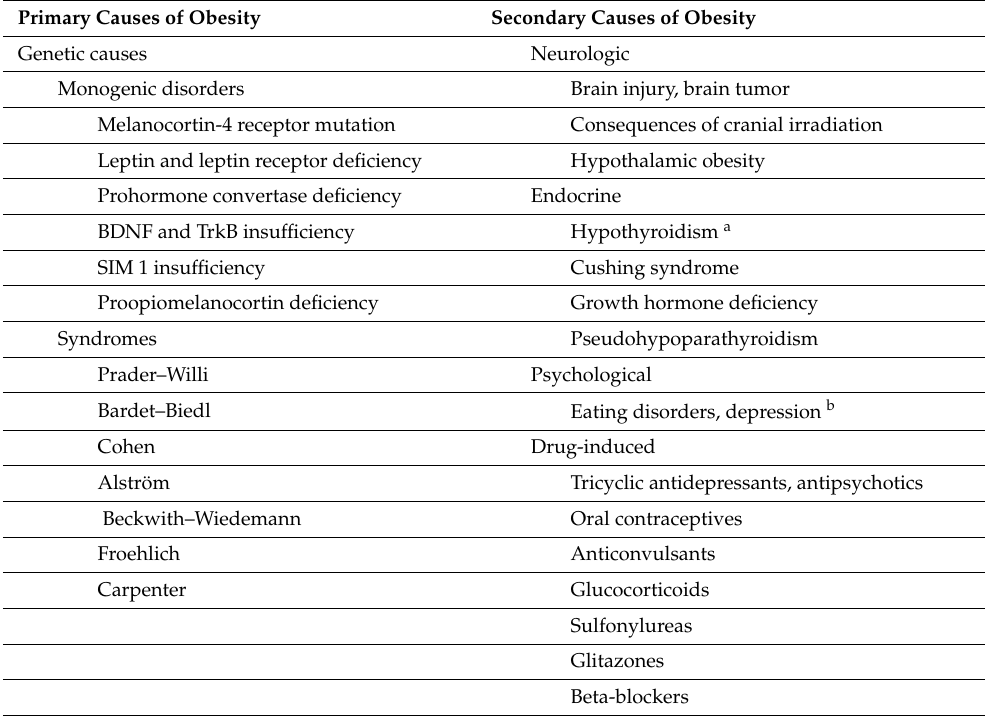
Table 1. Primary and secondary disease-related causes of